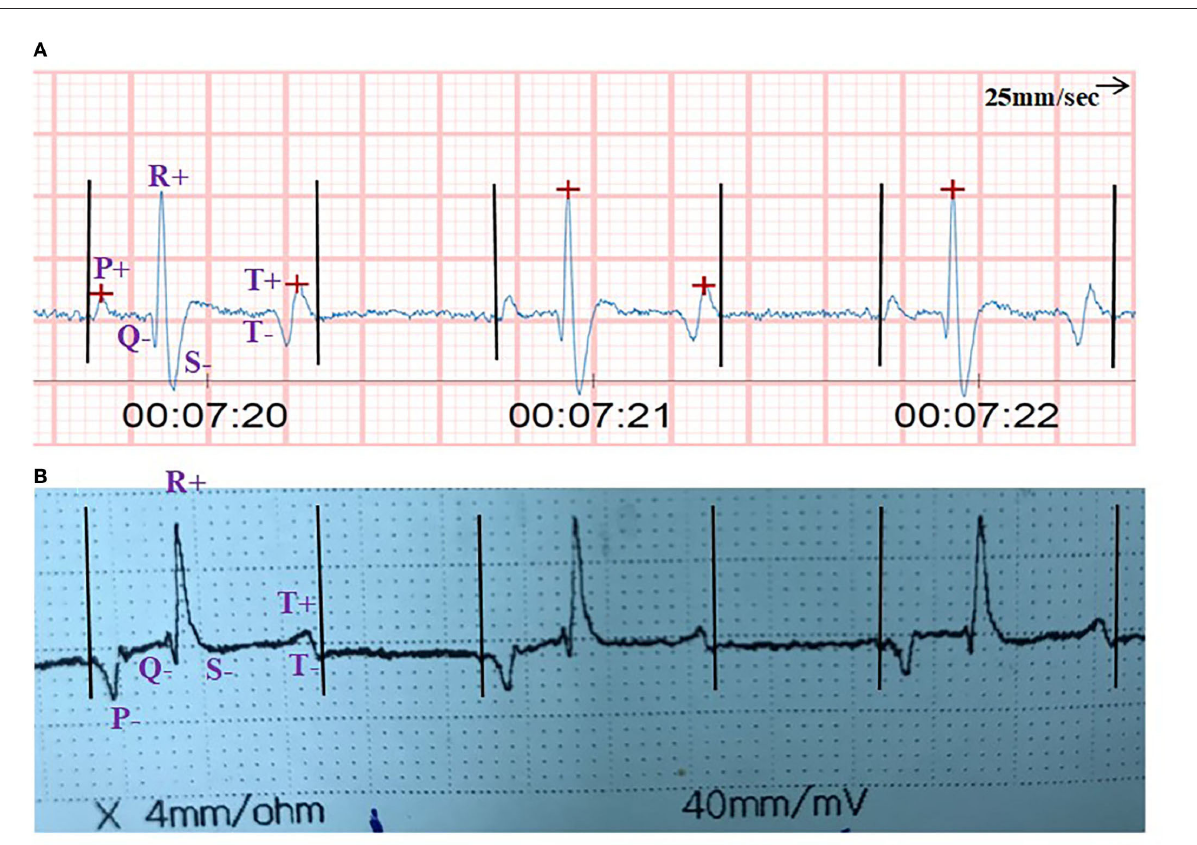
FIGURE2 Show ECG tracing from (A) Equimetre TM (B) Gold standard base-apex for clinical female calf. Camel suffering cloudy eyes referred to King Faisal veterinary teaching hospital. Variation between Equimetre TM and Base-apex system in the complex morphology was noticed, P-Wave showed different polarity ( + ) in Equimetre TM and (-) in base-apex. Moreover, absence of S-Peak in base-apex system compared to Equimetre TM where S-Peak is present and clear. Additionally, Q-Wave, R-Wave, and T-Wave determined in both devices with respect to the difference between the device in terms of duration and